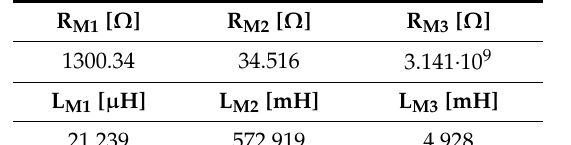
Table 2. The values of resistances and inductances calculated for the Cauer circuit representing the magnetizing branches of the transformer equivalent circuit.